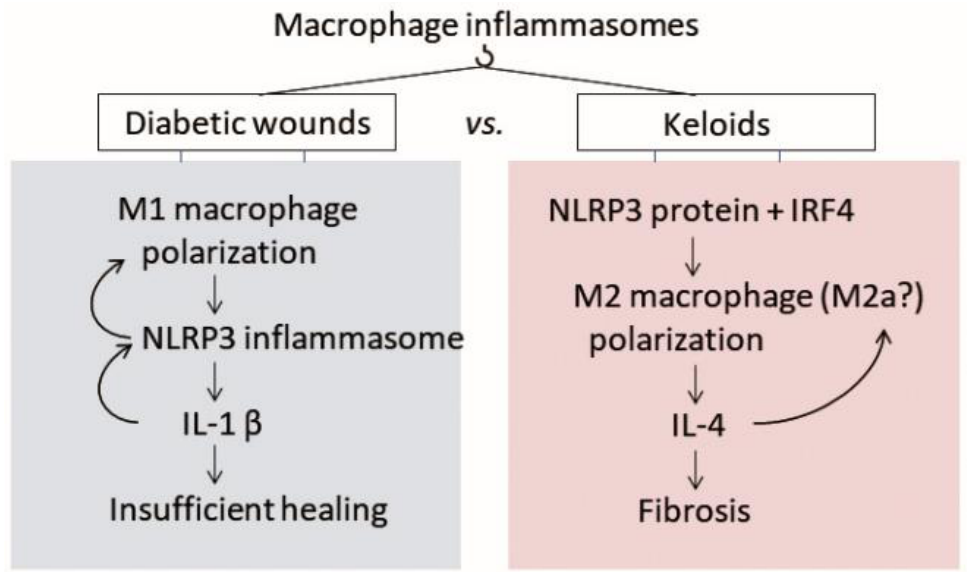
Figure 2. Known roles of inflammasomes in diabetic wounds and hypothetical roles of inflammasomes in pathological scarring.